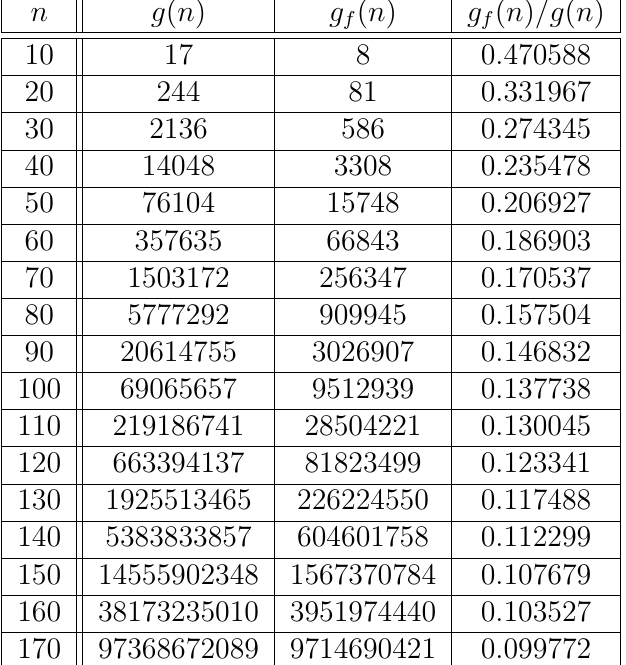
Table 8: Number of forcibly connected graphical partitions of n and their proportions in all graphical partitions of n